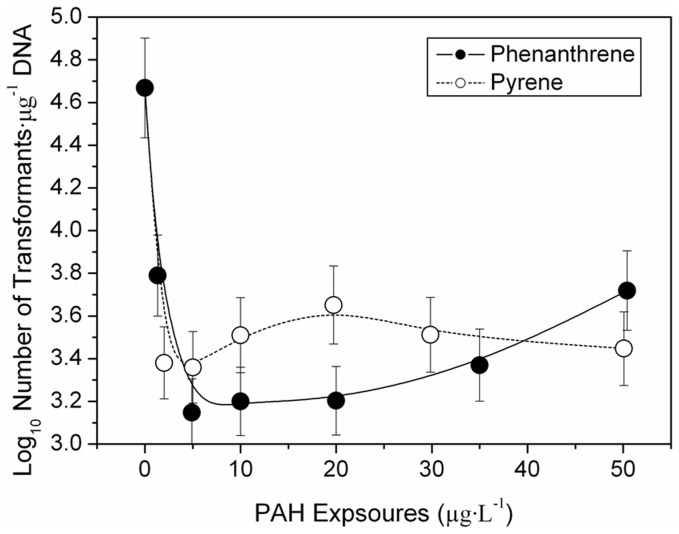
The transformation efficiency of plasmid DNA as a function of phenanthrene/pyrene concentrations.The transformation efficiency was calculated according to Equation I. Error bars represent 1 standard deviation (n = 3).